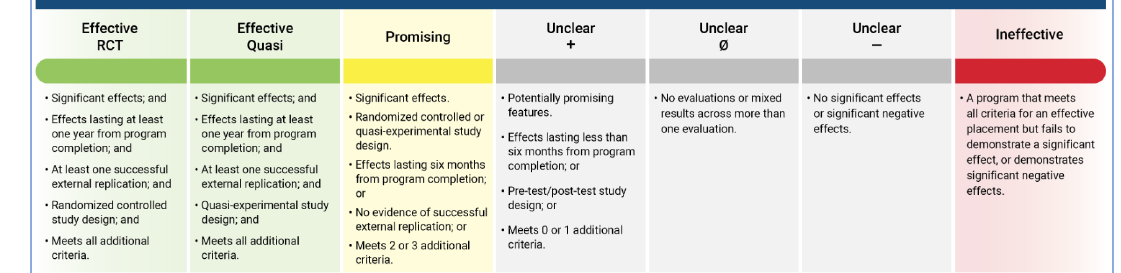
Source: Continuum of Evidence: Clearinghouse for Military Family Readiness